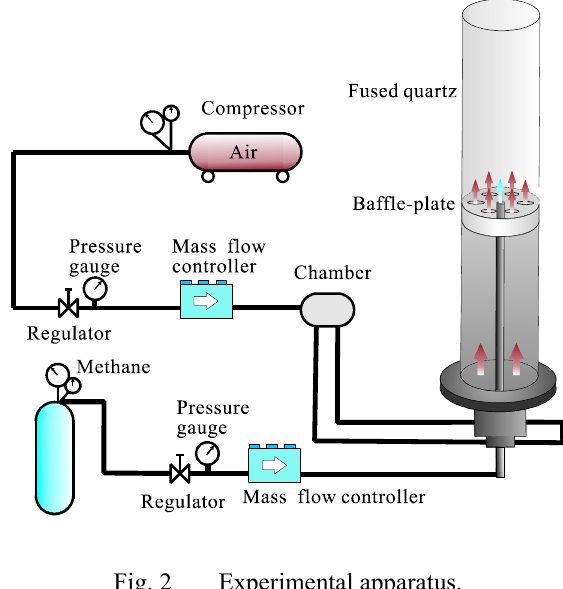
Fig. 2 Experimental